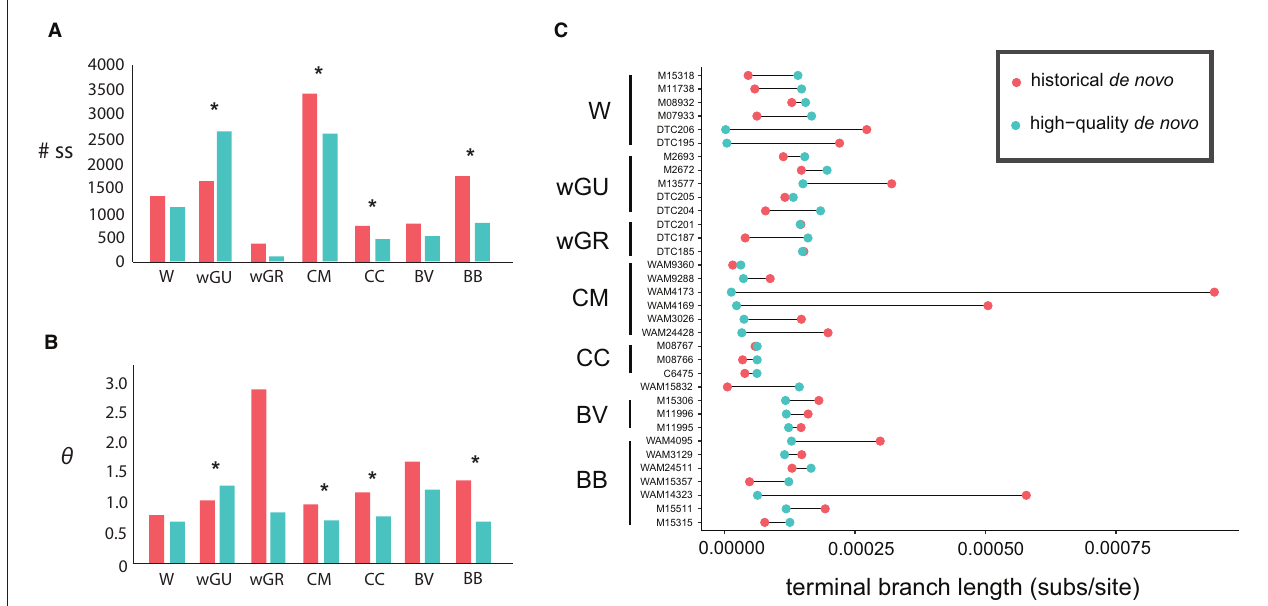
FIGURE 2 | Comparison between the “historical de novo ” (pink) and “high-quality de novo ” (blue) datasets for (A) total number of segregating sites, and (B) average Watterson’s theta ( θ ) estimates, and (C) terminal branch length (substitutions per site). Samples are identified by the voucher number and grouped by population; W, wilkinsi ; wGU, wilkinsi Gulf of Carpentaria; wGR, wilkinsi Groote Eylandt; CM , concinna monastria ; CC , concinna canescens ; BV , brachyotis victoriae ; BB, brachyotis brachyotis . Significant differences between the “historical de novo ” and “high-quality de novo ” datasets for each population are designated by * in (A,B)